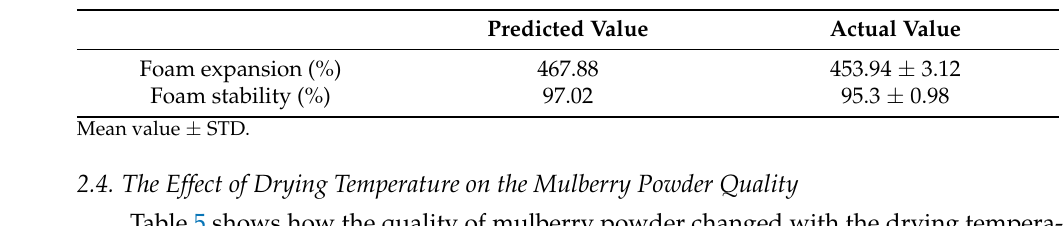
Table 4. The predicted and actual values of responses from ideal conditions.